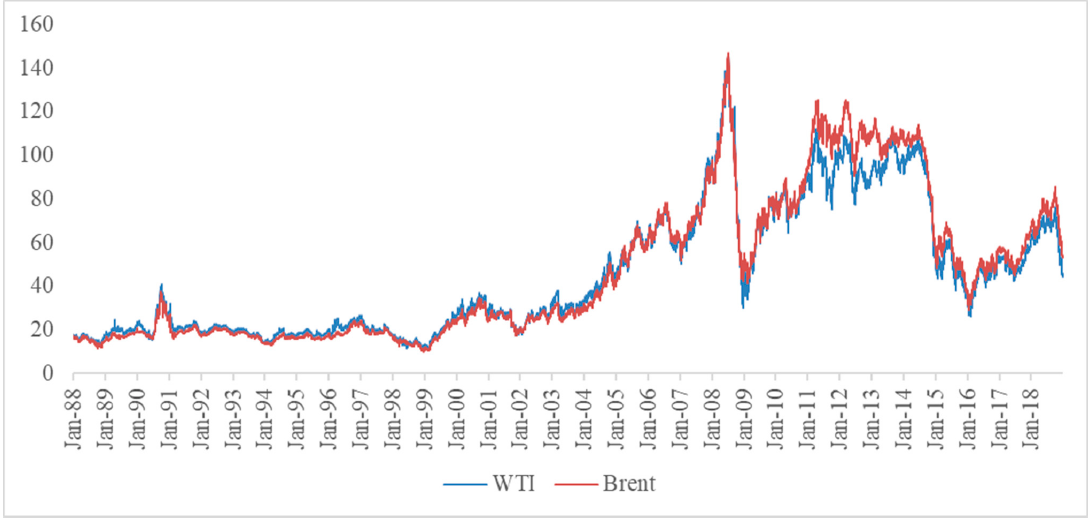
Figure 1. The plots of the raw data for the WTI and Brent crude oil prices.